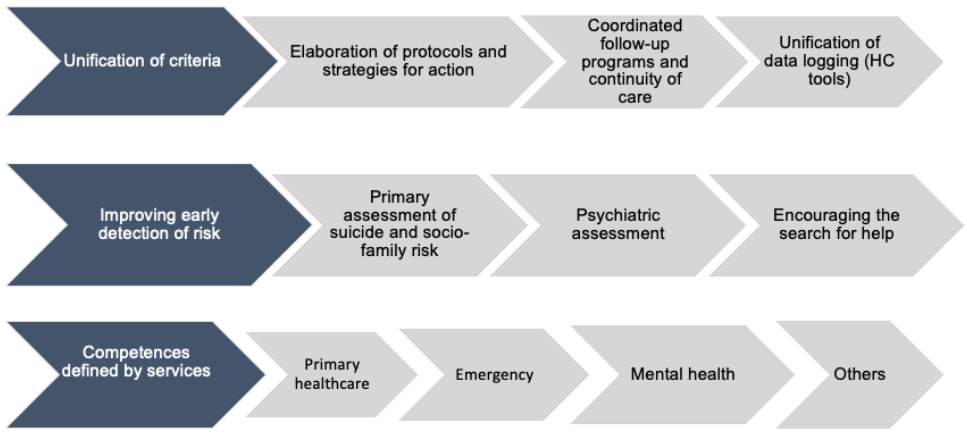
Figure 3. Classification of health interventions.